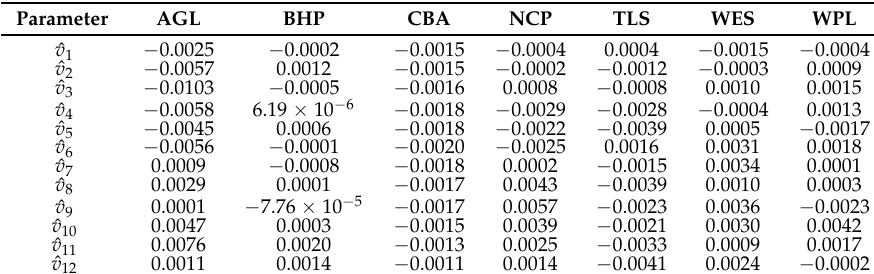
Table 5. Cross-autocorrelation coefficents ˆ v j , j = 1,...,12 of generalised residuals with lagged generalised fitted price